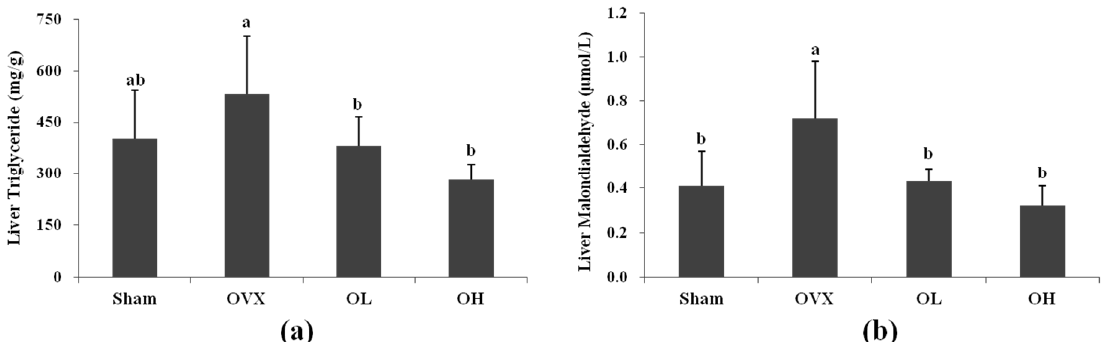
Figure 5. Liver triglyceride and malondialdehyde of each group. ( a ) Liver triglyceride; ( b ) Liver malondialdehyde. Values are mean ± SD ( n = 7 for each group). The different letters (a > b > c) within a column indicate significant differences ( p < 0.05) determined by Duncan’s multiple range test; Sham, the non-OVX control; OVX, the OVX-control; OL, the OVX + 100 mg/kg b.w. of hawthorn extract; OH, the OVX + 200 mg/kg b.w. of hawthorn extract.